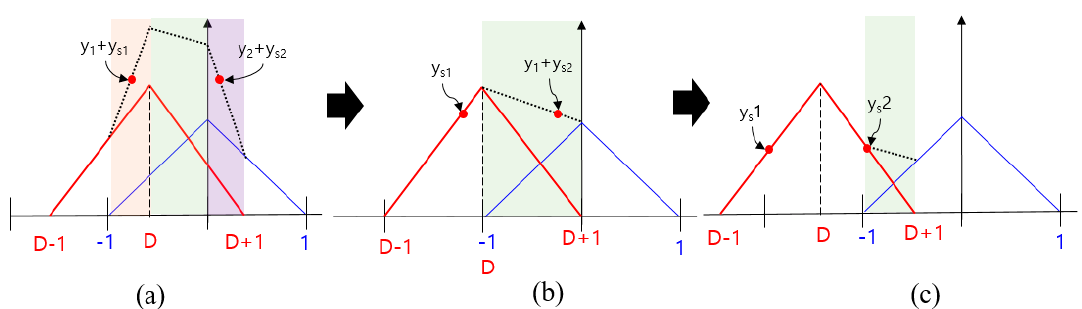
Figure 8. ACF change according to the spoofing signal in case that spoofing signal strength is larger than authentic signal strength. ( a ) − 1 < D < 0; ( b ) D = 1; ( c ) D < −